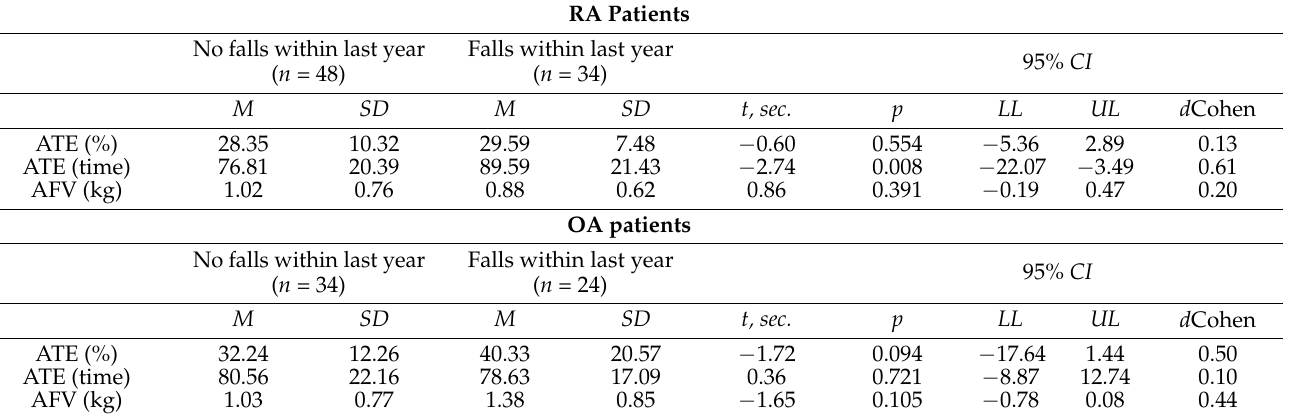
Values represented as mean ( M ) with standard deviation ( SD ); LL stands for lower level and UL stands for upper level of confidence interval. It was observed that in the group of patients with RA, the time of proprioception assessment completion was statistically significantly higher in subjects who reported at least one fall in the last year than those who did not report falls ( p < 0.05, and medium effect size d = 0.61) (Table 7). Table 7. Comparison of the results of functional proprioception assessment between groups with and without falls with RA and OA. RA